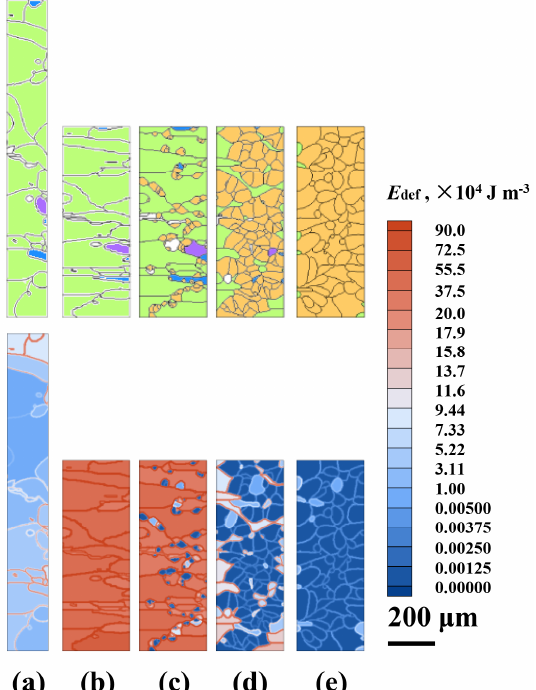
Figure 7. CA-simulated evolution of the grain structure (upper row) and deformation-stored energy (lower row) during the 4th pass and interval: ( a ) t = 0.0 s; ( b ) t = 0.1 s, the end of deformation; ( c ) t = 1.0 s; ( d ) t = 5.0 s; ( e ) t = 21.8 s. In the upper row, the purple, blue, green, yellow grains represent recrystallized grain generated in the 1st, 2nd, 3rd, 4th pass and interval, respectively. The horizontal and vertical directions are the rolling and compression directions, respectively.